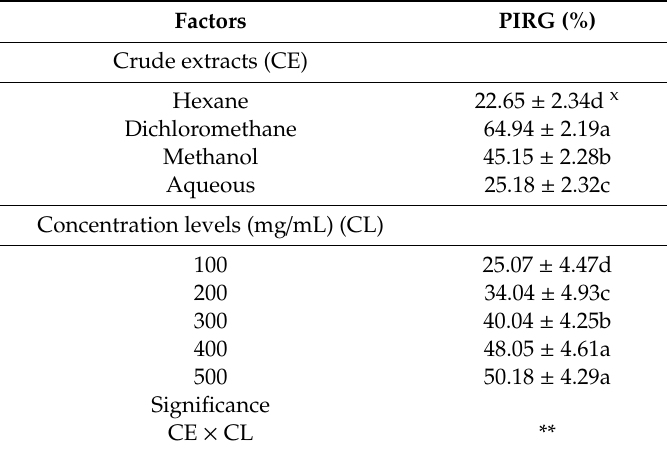
Table 1. Main and interaction e ff ects of V. amygdalina crude extracts and concentration level on PIRG of B. cinerea . PIRG: percentage of radial